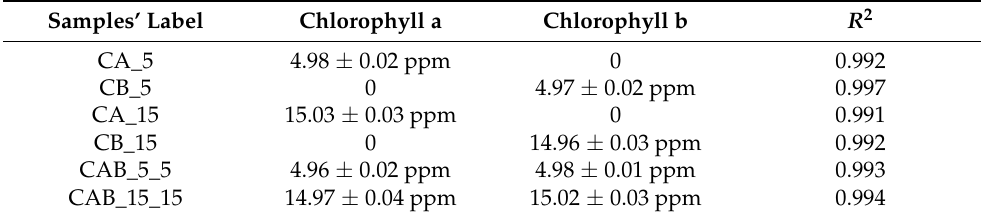
Table 2. Values of chlorophyll a and chlorophyll b (ppm) as obtained from the deconvolution method applied to the analysis of UV-vis absorption spectra of the test samples, prepared as reported in the text. The value of R 2 is also